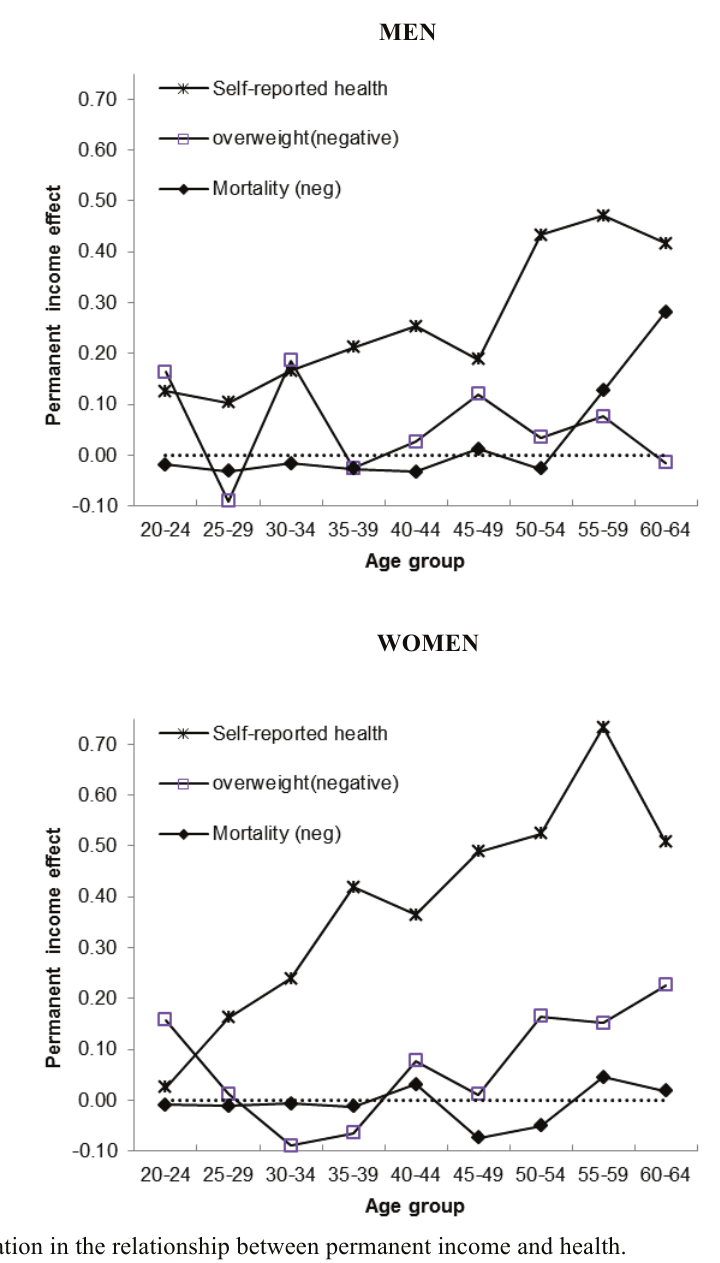
Fig. 5-6 Age variation in the relationship between permanent income and health. Notes: The size of the permanent income effect is on the y-axis and the x-axis describes the age groups. The permanent income effects for the age groups are estimated in a pooled OLS model (see equation 1). The measure of permanent income is an average of (at least) three yearly observations of the individual’s annual income. For comparability we change the sign of the income effects on overweight and mortality; otherwise these relationships go in the opposite direction compared to self-reported